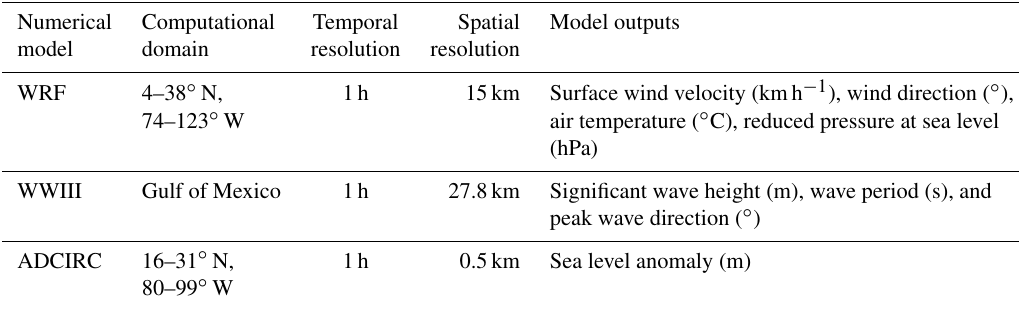
Table 2. Setup characteristics for the WRF, WWIII, and ADCIRC models. Numerical Computational Temporal